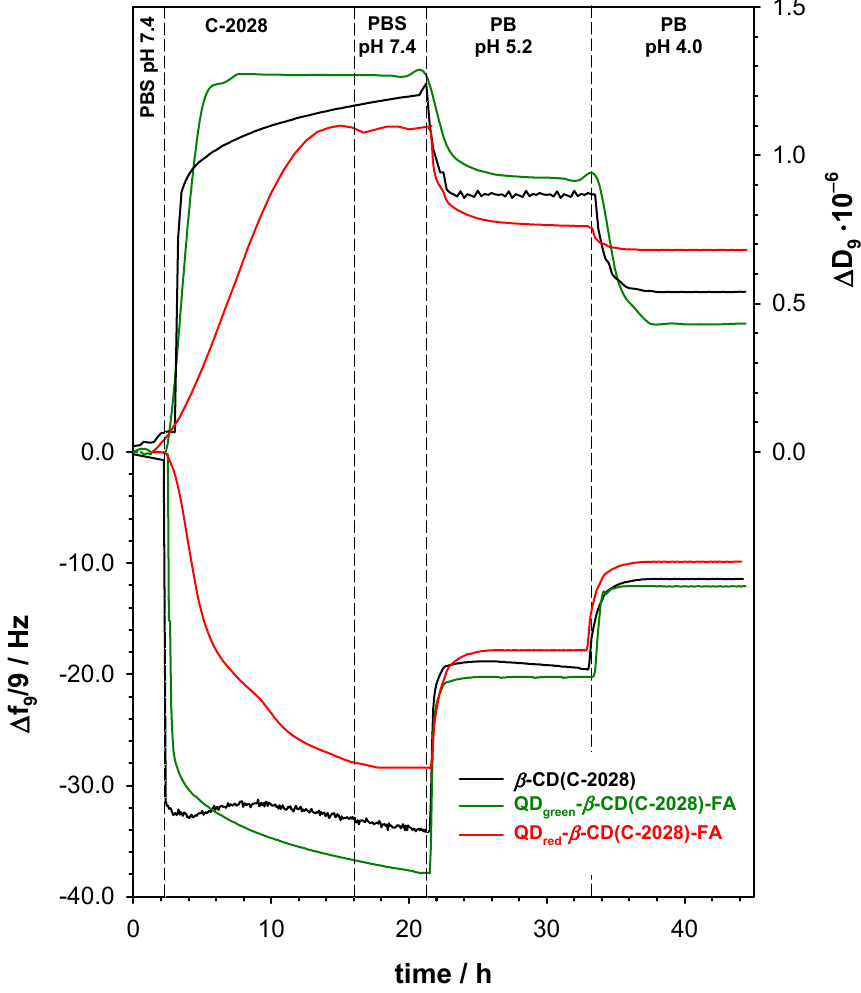
Figure 2. Typical QCM-D spectra of the shifts in frequency ( ∆ f ) and dissipation factor ( ∆ D ) recorded during the interaction of C-2028 with Au/QD- β -CD-FA (red and green lines) and Au/ β -CD (black lines), and nanoconjugates degradation in various pH solutions. Experimental conditions: 0.02 M PBS (pH 7.4); C QDs- β -CD-FA = 1.0 mg·mL − 1 ; C C-2028 = 300 μ M; C β -CD = 1.0 mg·mL − 1 .